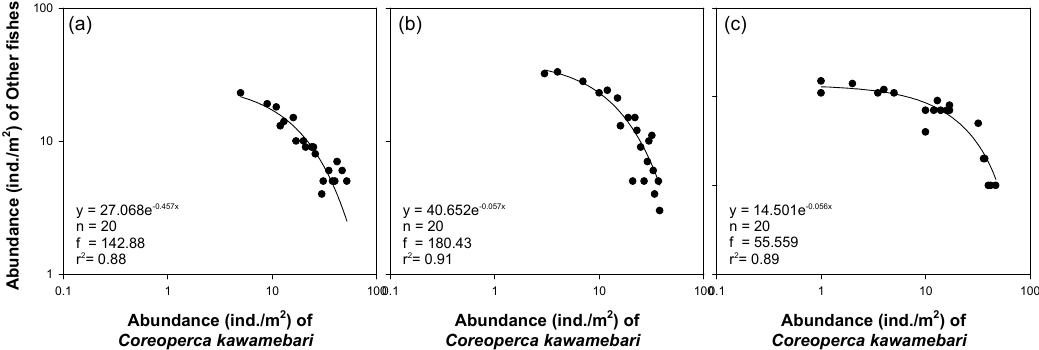
Figure 5. Relationship between abundance of Coreoperca kawamebari and fish abundance, excluding C. kawamebari , in the area covered by Ceratophyllum demersum types in three study sites (from the left, sites 2, 4, and 8) located in the upper parts of the Geum River. ( a ) site 2, ( b ) site 4, and ( c ) site 8.